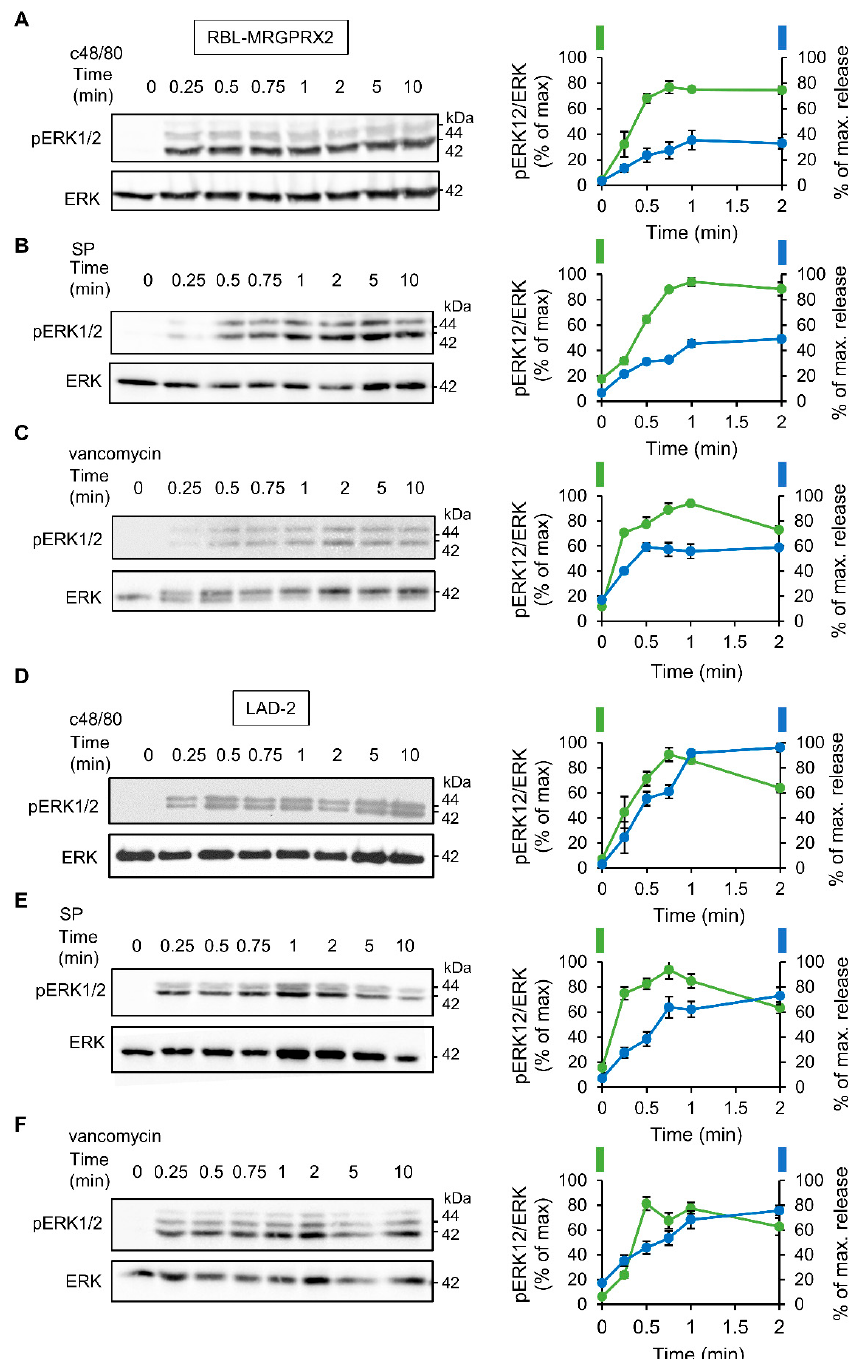
Figure 4. MRGPRX2-stimulated phosphorylation of the ERK1/2 MAP kinases shares similar kinetics in LAD-2 and RBL- MRGPRX2 cells. RBL-MRGPRX2 ( A – C ) and LAD-2 ( D – F ) cells (1 × 10 6 cells/mL) were incubated with 1 µ g/mL c48/80, 10 µ M SP or 1 mg/mL of vancomycin, at 37 ◦ C, for the indicated time periods. Cell lysates were resolved by SDS-PAGE and immunoblotted with anti-pERK1/2 antibodies, followed by reprobing with anti-total-ERK2 antibodies, as indicated. The intensities of the bands corresponding to phospho-ERK1/2 and total ERK2 were quantified by densitometry, using Image-J software, and the relative pixel densities (phosphorylated/total) were calculated and are presented as percentage of maximal response, in comparison with the percentage of the maximal secretory response at the same time points. Data are means ± SEM (n = 3–4). Representative blots are